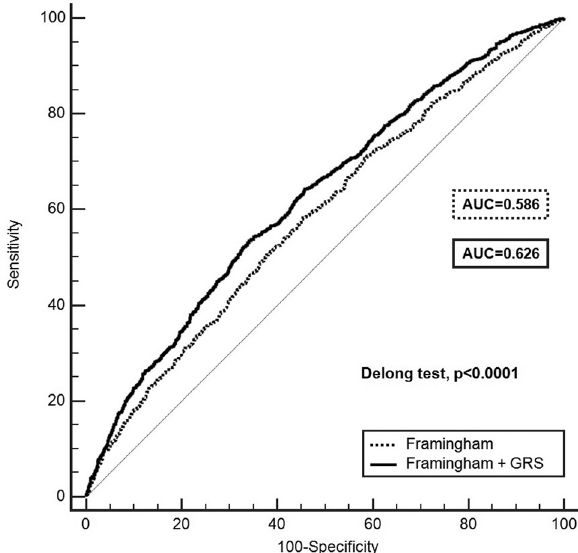
Figure 1 - ROC curves based on the GRS + Framingham model compard to Framingham model alone. The two curves are based on logistic regres- sion models incorporating Framingham risk with and without GRS. AUC indicates area under curve. The DeLong test compares the difference be- tween the two AUCs and showed statistical